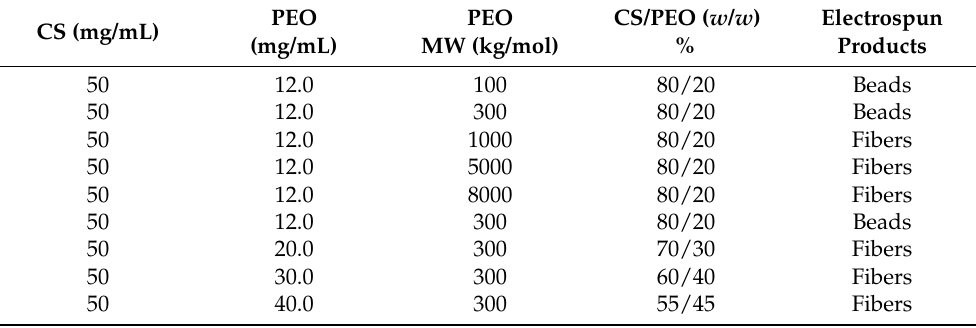
Table 1. Composition of electrospun solutions obtained from powdered poly (ethylene oxide) (PEO), with different molecular weights, added into chitosan (CS) (molecular weight (MW) = 102 kg/mol) in 0.5 M acetic acid solution